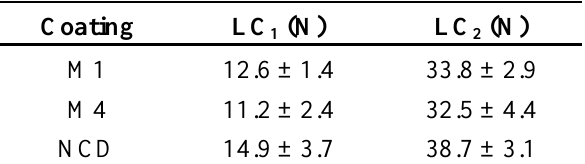
Table 2. Summary of critical loads for cohesive failure (LC for multilayered coatings M1 and M4 and single-layered NCD